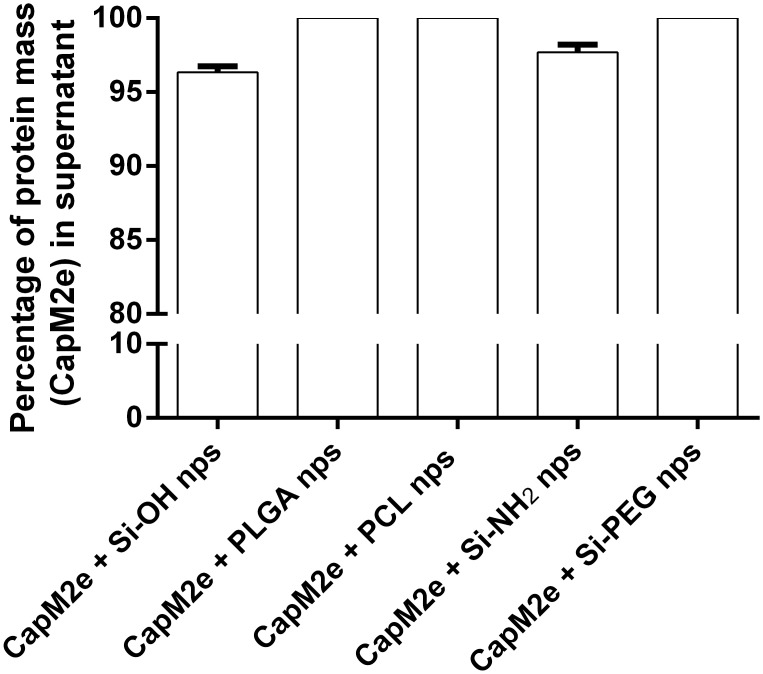
Percentage of protein mass (CapM2e) in supernatant after mixing with different nanoparticle solutions.